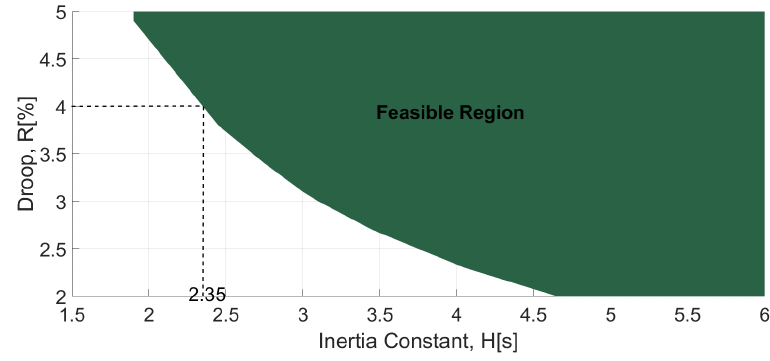
Figure 14. Feasibility of different R for different H for Wind